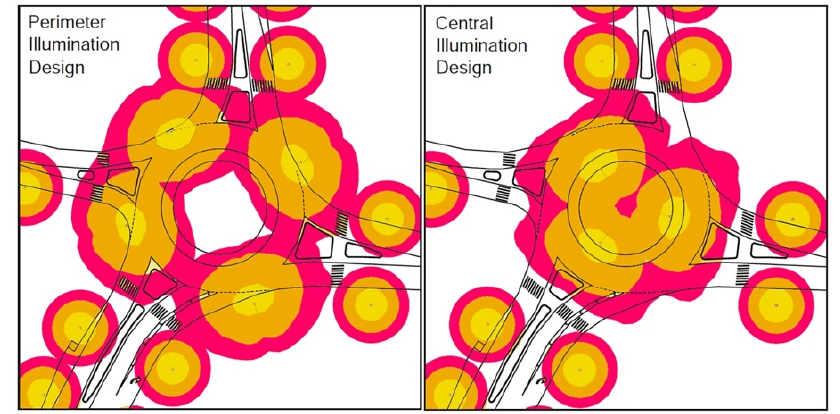
Figure 1. Photometric illustration of perimeter and central illumination design.